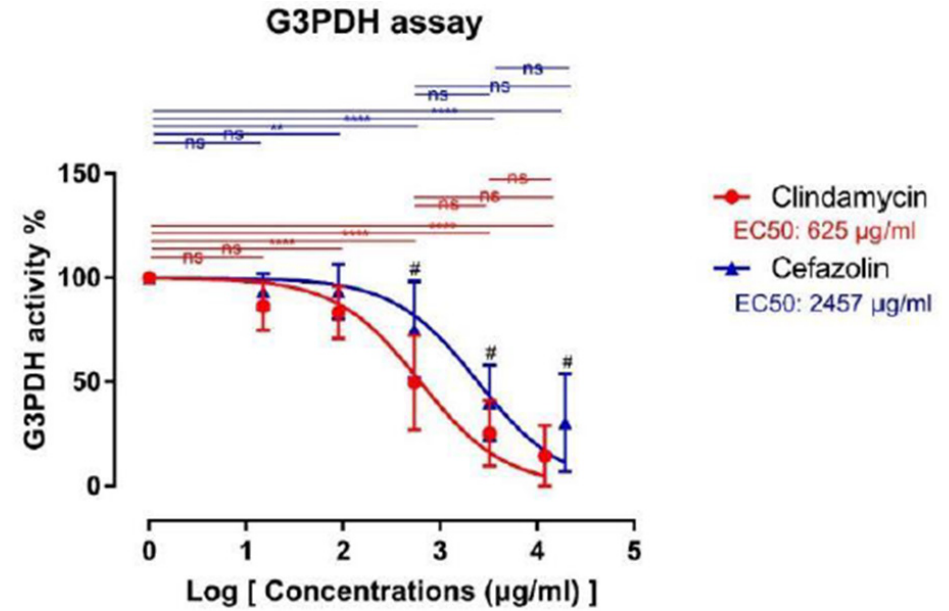
Figure 4. Sigmoidal dose-response curve for G3PDH assay. Data are shown as mean ± standard deviation. Asterix denotes statistically significant difference vs. the control group (ns = not significant; ** = p < 0.01; **** = p < 0.0001). Brackets indicate statistically significant differences between corresponding groups of clindamycin and cefazolin treated adipocytes (# p= < 0.05). ns means non-significant. EC50 characterizes the concentration leading to a 50% reduction.